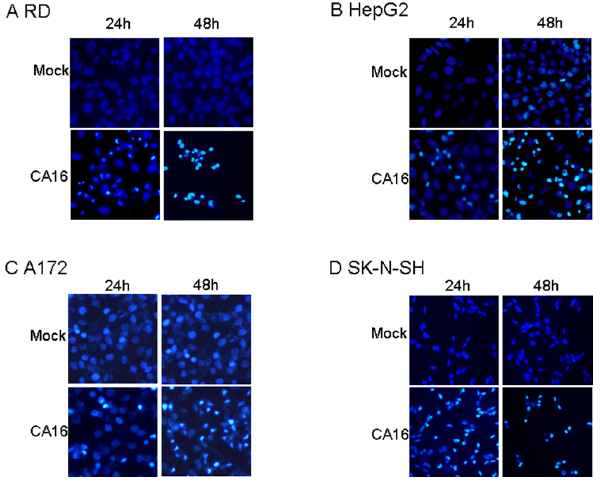
Figure 2. Nuclear fragmentation occurs in CA16-infected cells. (A) RD, (B) HepG2, (C) A172 and (D) SK-N-SH cell lines were inoculated with CA16 SHZH05 virus at the MOI of 0.2 or DMEM as a negative control. After 24 h or 48 h of infection, cells were stained with Hoechest 33258. Nuclear fragmentation was observed via fluorescence micros- copy. Representative images are shown of three individual experiments (n=3) performed for each cell line.